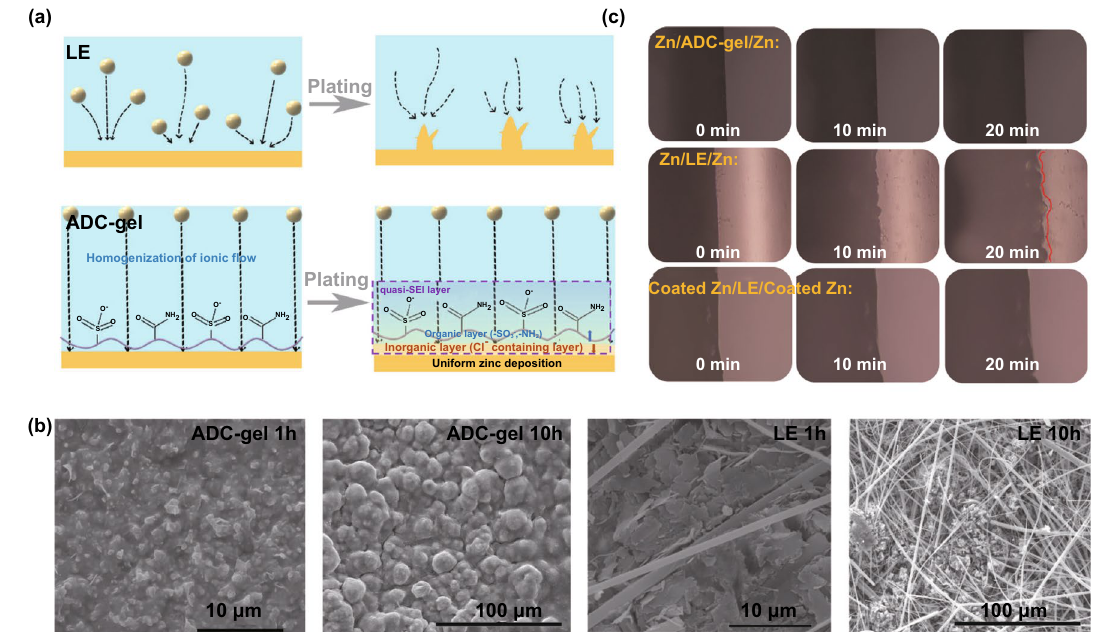
Fig. 5 a Schematic illustration of the Zn deposition behavior on the anode surface in different electrolytes. b SEM images of the deposition of 1 and 10 h Zn on Cu foils in ADC-gel and liquid electrolytes at the current density of 1 mA cm −2 . c In situ optical microscope observing the Zn deposition at a voltage of 4 mV in Zn//Zn symmetric cells to investigate the validity of SEI